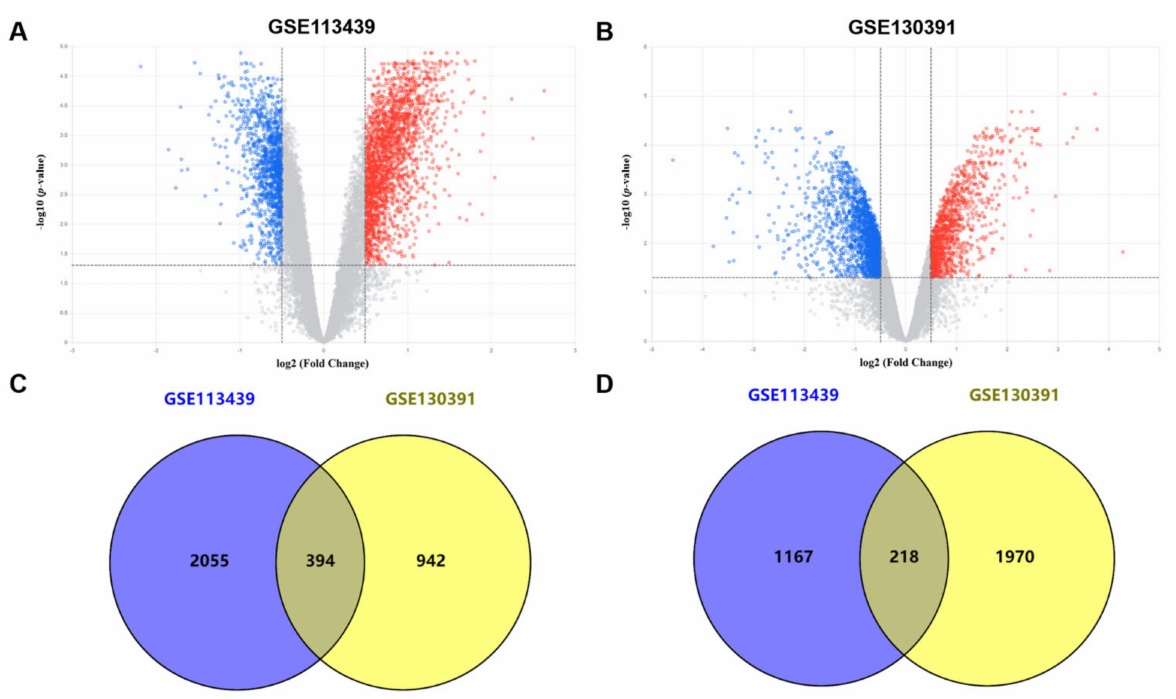
Figure 1. DEGs in microarray data sets GSE113439 and GSE130391. ( A , B ) Volcano plots of DEGs distributions for the two data sets. A red spot represents an upregulated DEG, and a blue spot represents a downregulated DEG, while a gray spot represents a non-DEG. ( C ) DEGs upregulated simultaneously in both data sets. ( D ) DEGs downregulated simultaneously in both data sets. DEG: differentially expressed